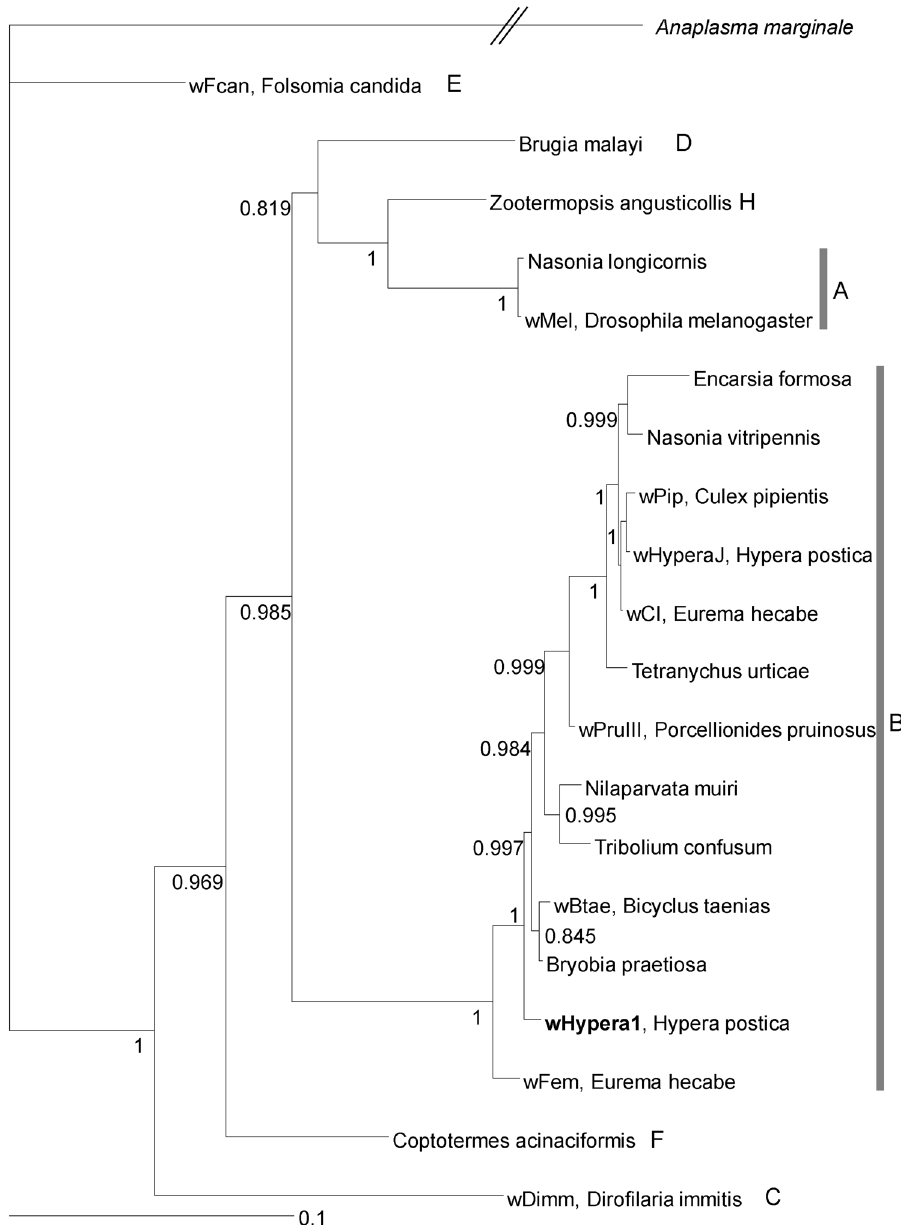
Figure 4. Bayesian consensus tree of Wolbachia strain based on ftsZ , coxA, and hcpA . Strain codes, if available, followed by host species and Wolbachia supergroups are shown. The Wolbachia strain, wHypera1, infecting Hypera postica in its native range, is shown in bold. Bayesian support values (posterior probabilities > 0.7) are shown near nodes. The outgroup is Anaplasma marginale (Alphaproteobacteria: Rickettsiales: Anaplasmataceae) . Generated using MrBayes 3.2.6 73 . Host strains, Wolbachia isolates and GenBank accession numbers are listed in Supplementary Table S3.